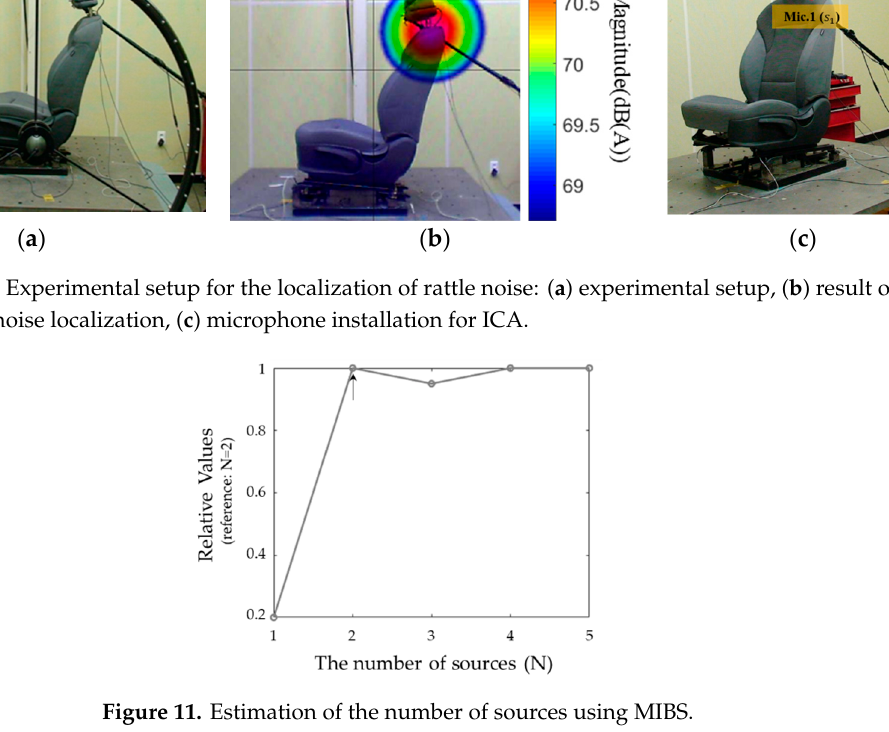
Figure 11. Estimation of the number of sources using MIBS.